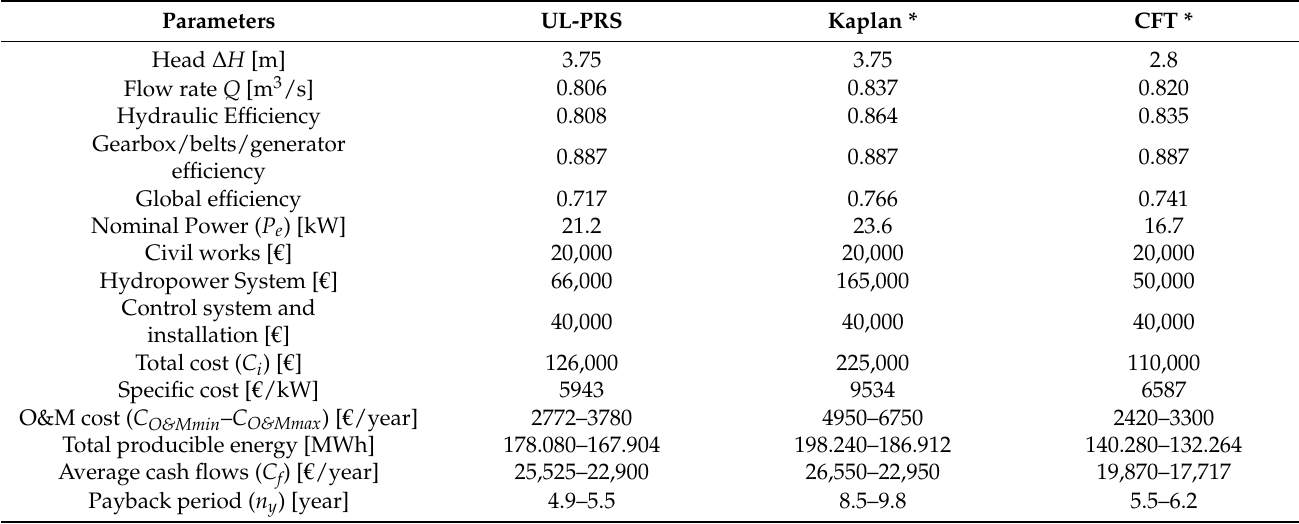
Table 4. Comparison of economic